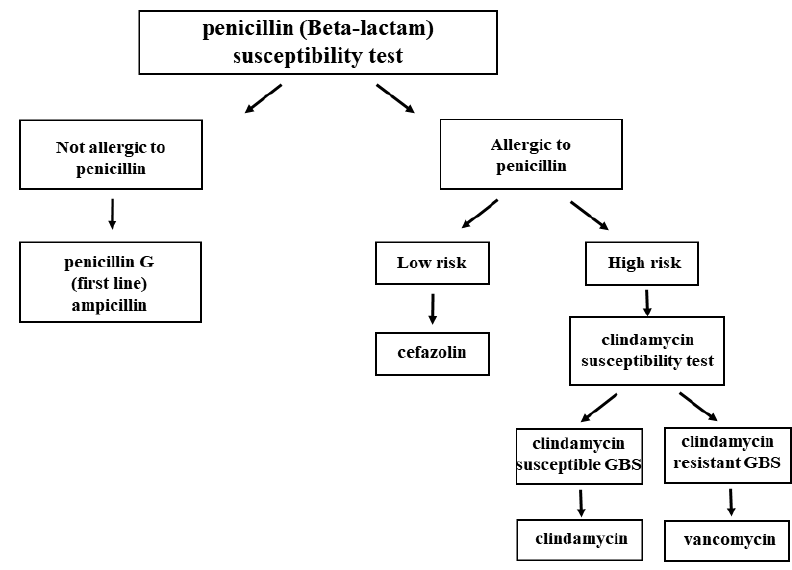
Figure 2. The algorithm recommended by the CDC for IAP treatment